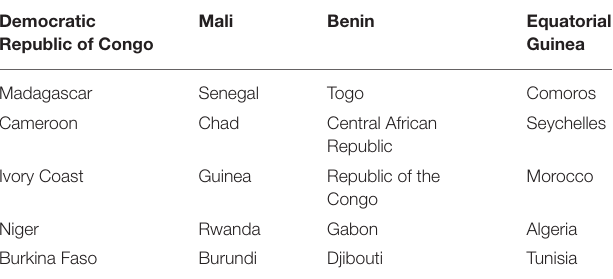
TABLE 2 | French-speaking countries in Africa which will be used in the